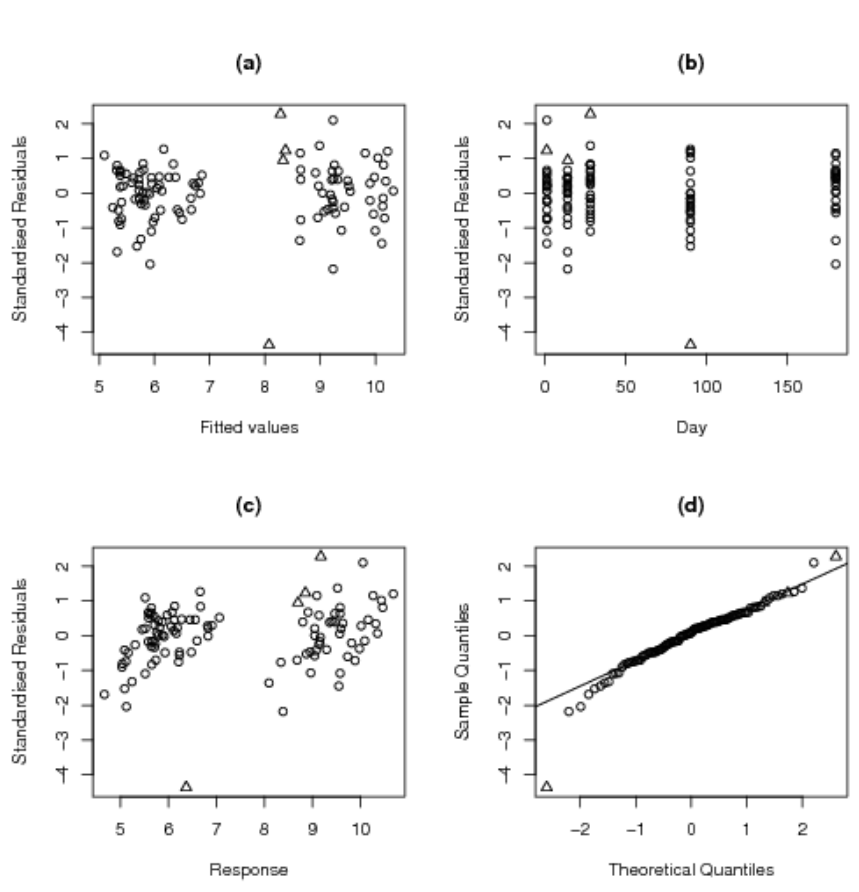
Figure 2 – Residual analysis for the TUBB2A model fit. (a) Standardised residuals against fitted values (b) Standardised residuals against time (c) Standardised residuals against observations (d) QQ-plot of standardised residuals. These plots can be used to detect patterns in the data which the model has failed to capture. Aside from the obvious groupings as a result of the difference in gene expression levels between males and females, there appears to be little structure to the residuals. In all cases, the triangles correspond to observations on subject 174, who developed lung cancer during the course of the study and died prior to the final time point. It can be seen that this subject contributes two obvious outlying residuals, which may have negatively impacted the goodness of fit criteria calculated by Karlovich et al. (2009), possibly resulting in its removal from any subsequent